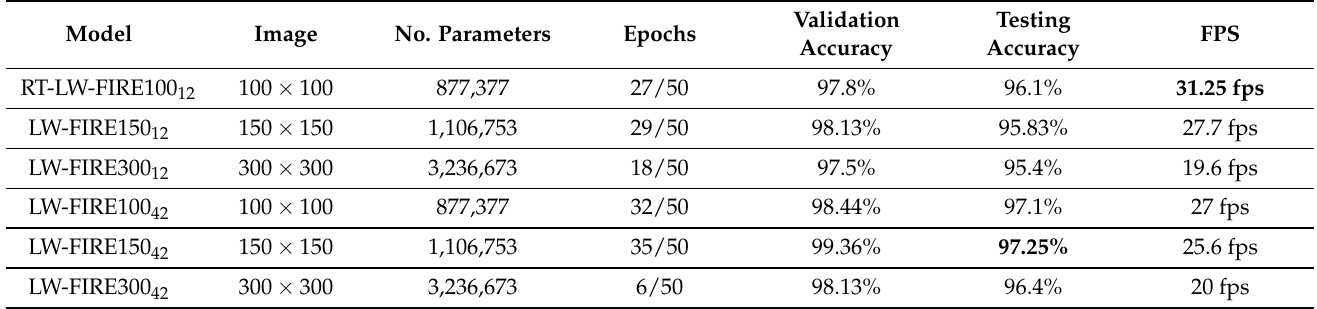
Table 5. Different configurations and their performance measures for N = 12 and N =